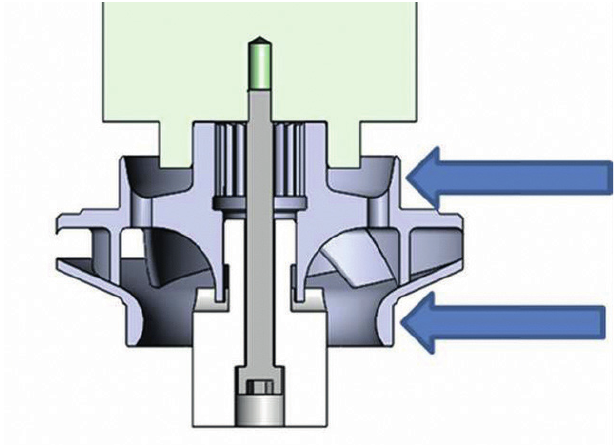
Figure 11. Measurement positions for impellers A and B on seal